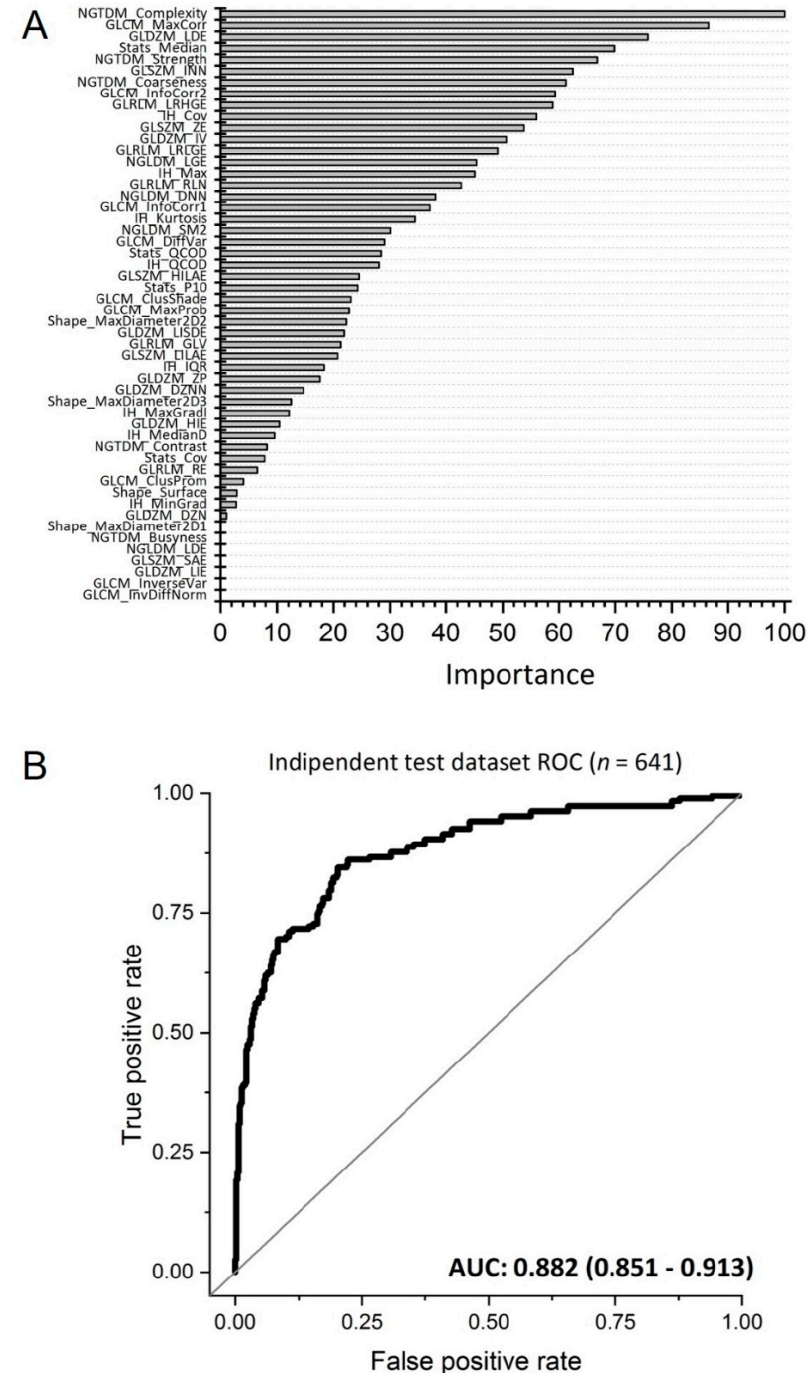
Figure 4. ( A ) Features with a non-zero regression coefficient in the model and their importance, based on their absolute regression coefficient, and scaled between 0 and 100; ( B ) ROC plot illustrating the performance (black curve) of the AI framework to discriminate between COVID-19 positive and negative cases in the independent test data set with an area under the receiver operating characteristic curve (AUC) of 0.882 (95% CI: